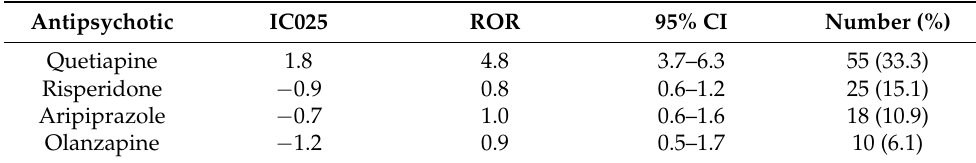
Table 9. Disproportionality analysis for main antipsychotics involved in reports of abuse in patients aged between 12 years and 17 years, ranked by